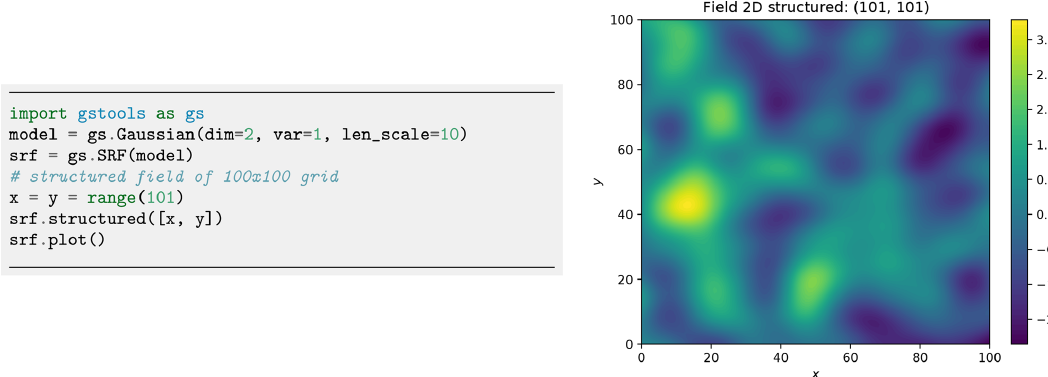
Figure 11. Generation of a structured random field following a Gaussian variogram.